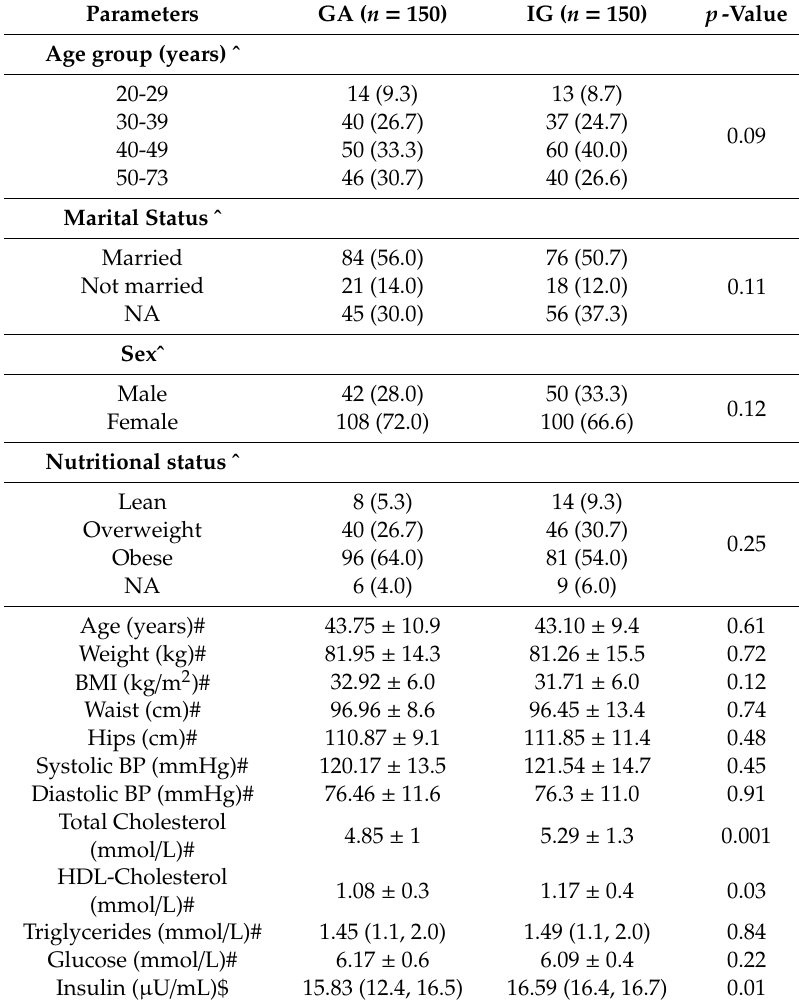
Table 2. Baseline anthropometric and biochemical characteristics of all study